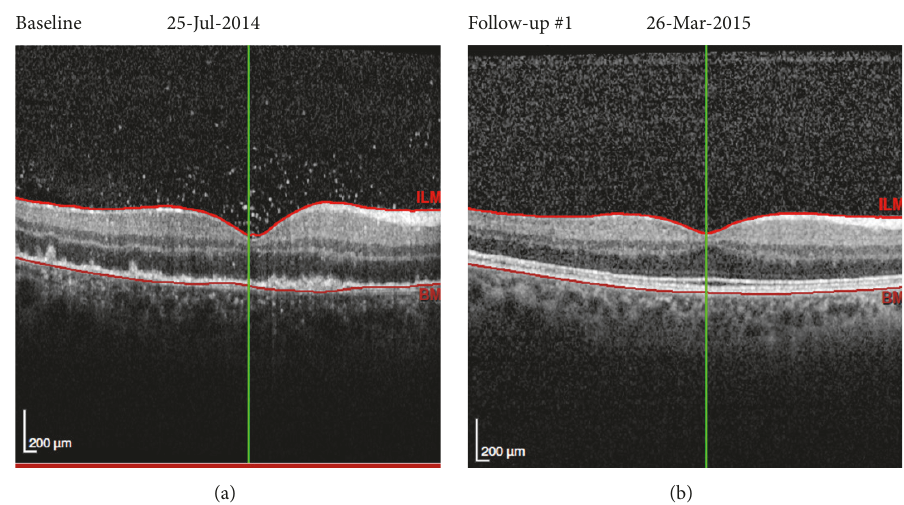
Figure 2: Macular optic computed tomography of right eye, during active disease (a). Small vitreous inflammatory agglomerates and inflammatory deposits in neurossensorial retina; diffuse macular thickening. After resolution